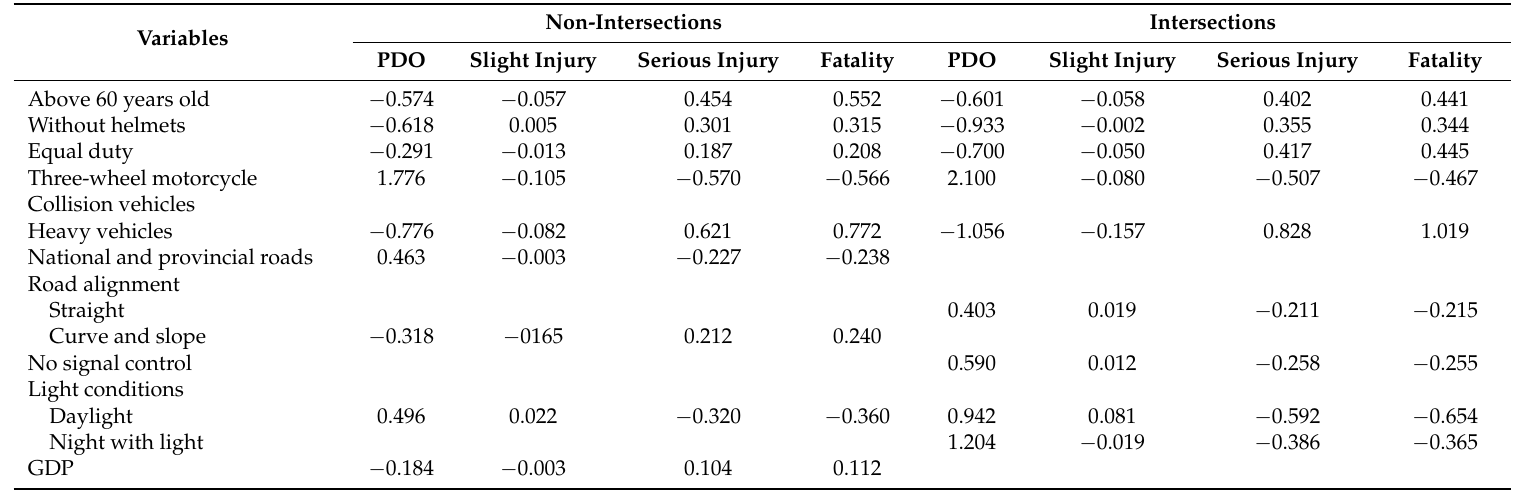
Table 4. Estimate results for marginal effects of risk